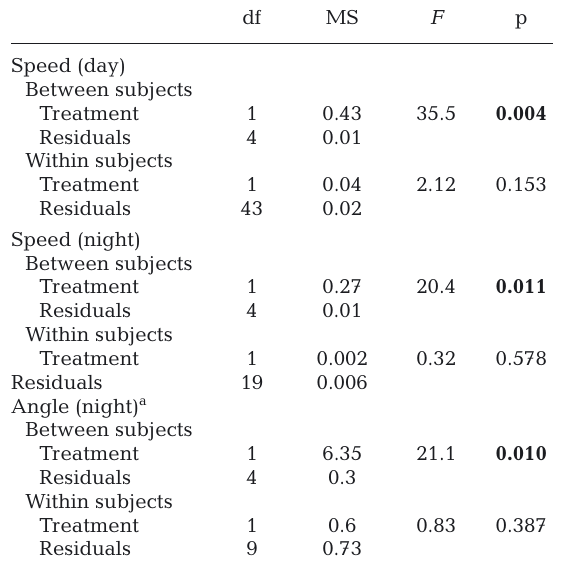
Fig. 3. Swimming behaviour of salmon reared in submerged (triangles) and surface (circles) cages for 42 d: (a) swimming speed in body lengths s −1 (n = 3 cages, 30 fish cage −1 ) during the day (black) and at night (grey), and (b) swimming angle, i.e. the angle between the anterior−posterior axis of the fish and the vertical reference line (n = 3 cages, 15 fish cage −1 ). Vertical dashed lines: time of submergence of submerged cages. Data are means ± SE